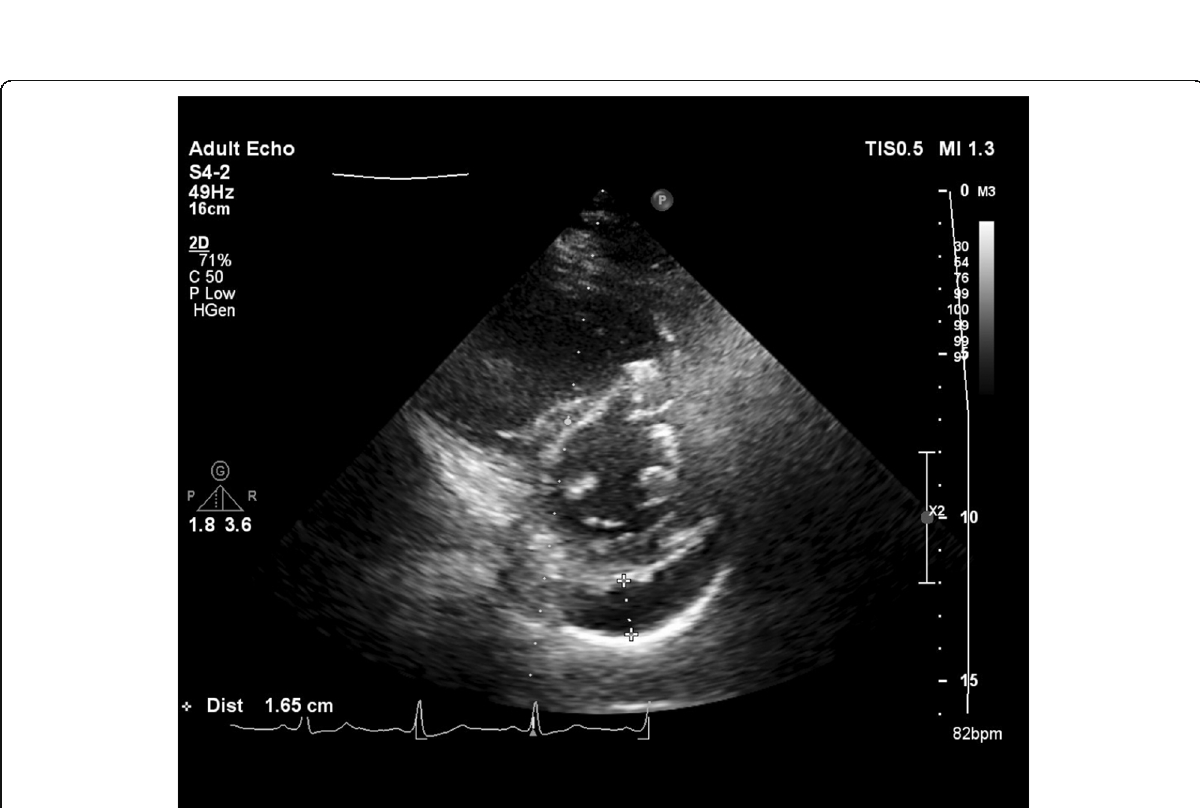
Fig. 5 Increased PE in the third patient after ASO implantation was seen in parasternal long axis TTE